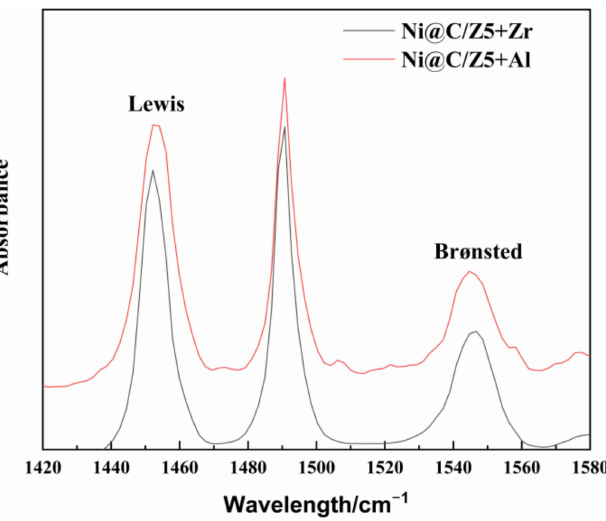
Figure 6. Py-FTIR spectra of Ni@C/Z5+Zr and Ni@C/Z5+Al at the desorption temperature of 350 ◦